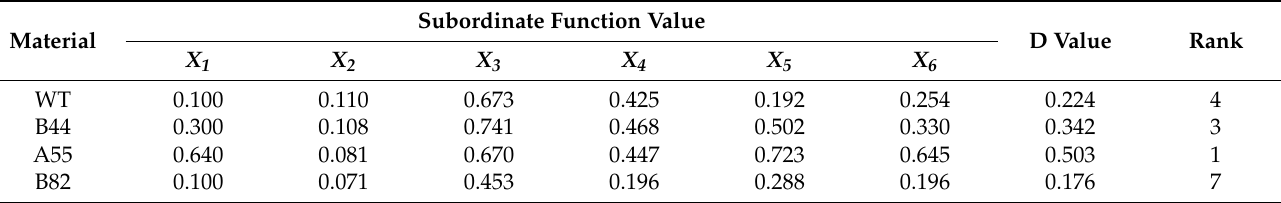
Table 4. A comprehensive evaluation of drought tolerance of 7